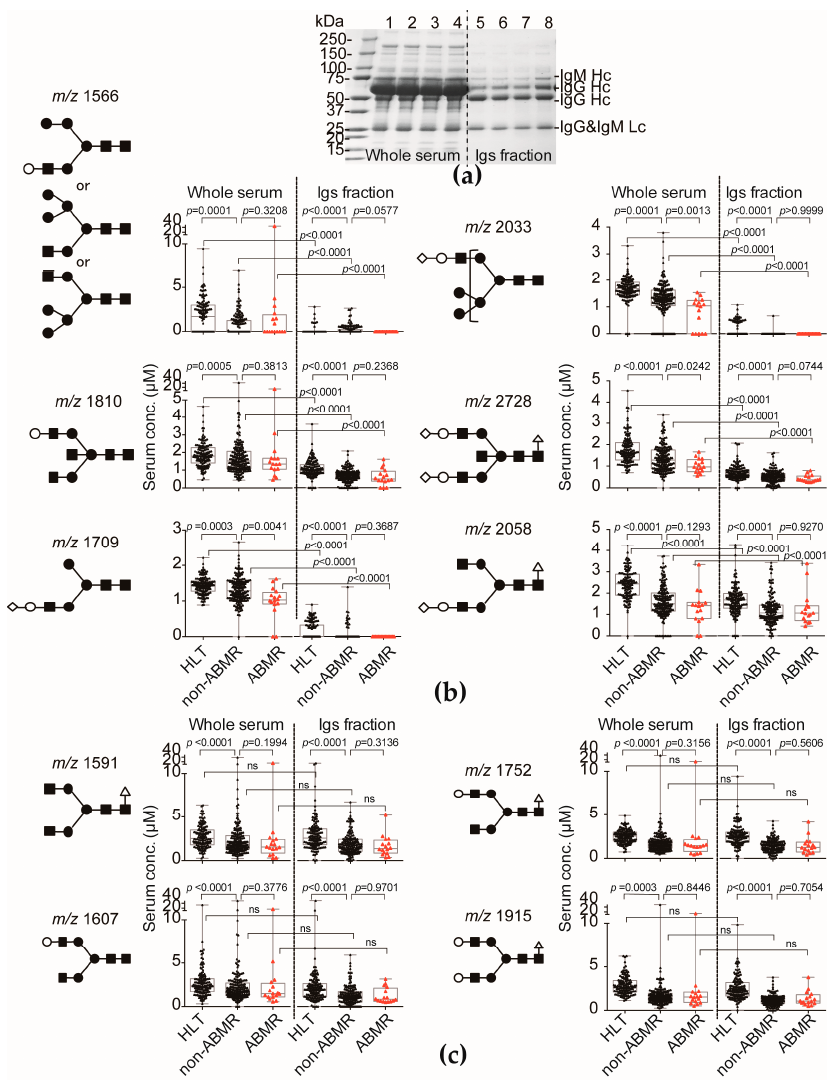
Figure 7. Levels of the ABMR-associated sialyl hybrid-type N -glycans in whole serum or in the immunoglobulin (Ig) fraction from patients before LKTx and on POD1. ( a ) CBB-stained band patterns on SDS-PAGE for representative whole-serum and purified Ig s fraction samples; ( b ) Levels of serum sialyl hybrid-type N -glycans ( m / z 1566, 1709, and 2033) and bisecting-type N -glycans ( m / z 1810, 2728, and 2058) in the whole-serum and Ig s fraction from non-ABMR and ABMR patients; ( c ) Levels of serum biantennary N -glycans ( m / z 1591, 1607, 1753, and 1915) in the whole-serum and Ig s fraction from non-ABMR and ABMR patients. Putative structures of N -glycans are indicated by monosaccharide symbols.